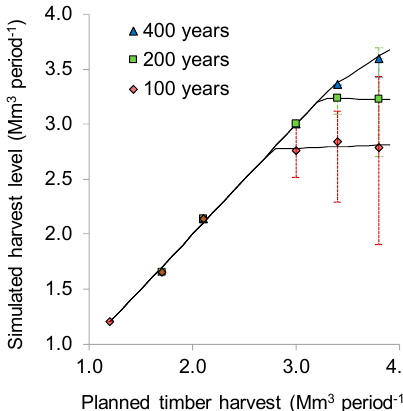
Figure 4. Relationship between planned timber harvest and its simulated implementation (median value) when considering the risk of fire for three fire cycles (100, 200 and 400 years). Parameters of the segmented linear models are provided in Table 1. Error bars represent the 5th and 95th percentiles of the probability distribution of simulated harvest levels.